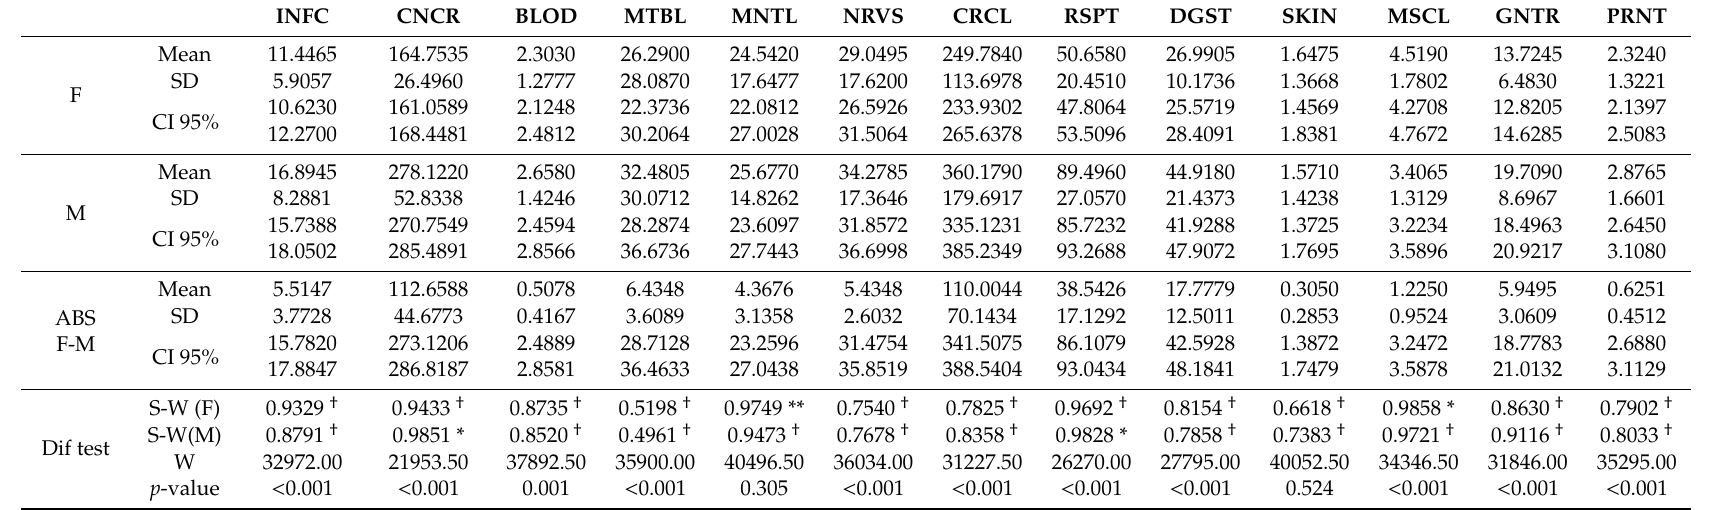
Table 1. Descriptive statistic and di ff erence